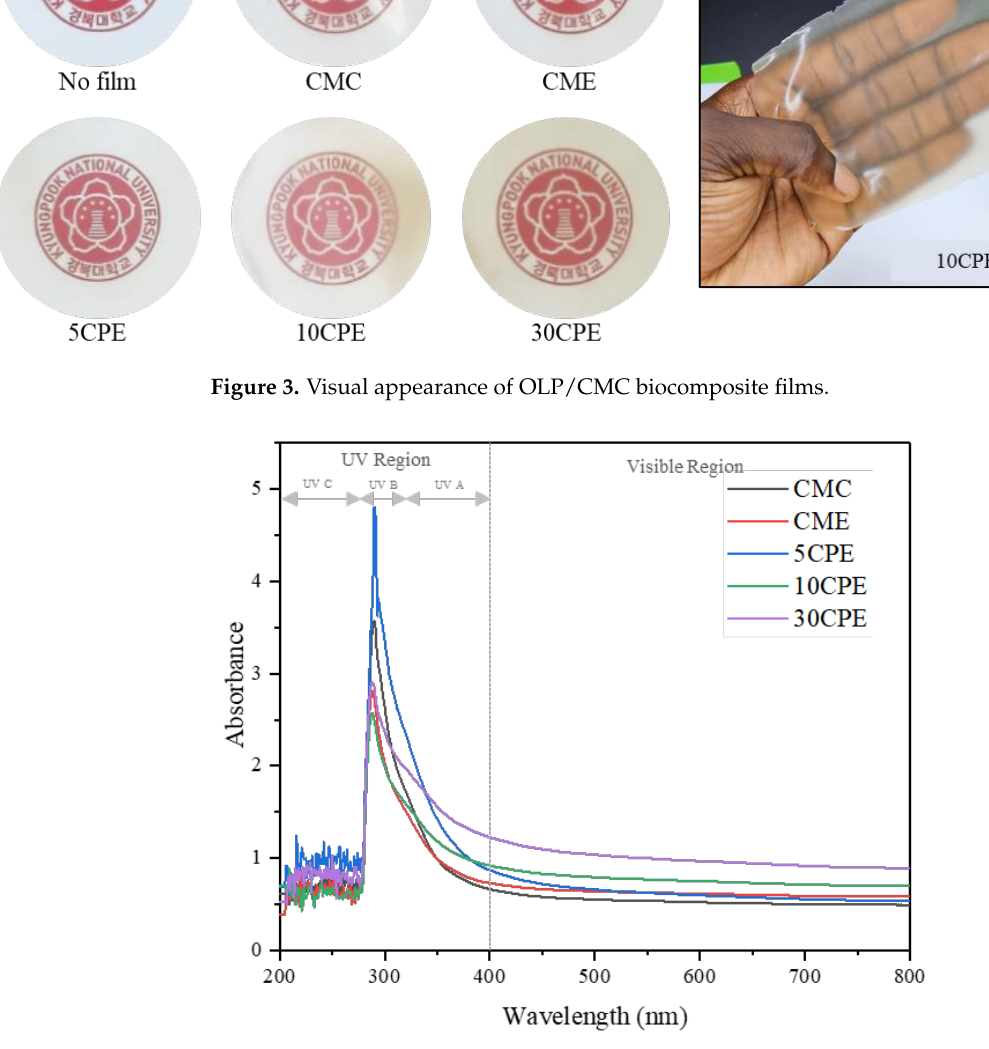
Figure 4. UV-vis light transmittance properties of films at 200–600 nm wavelength range. Table 3. Thickness and color properties of films.